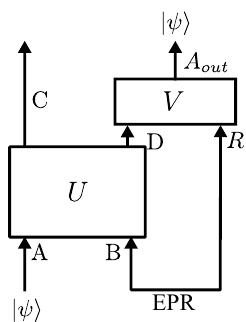
Figure 3 . The Hayden-Preskill thought experiment. U represents the time-evolution of the black hole and V represents a recovery